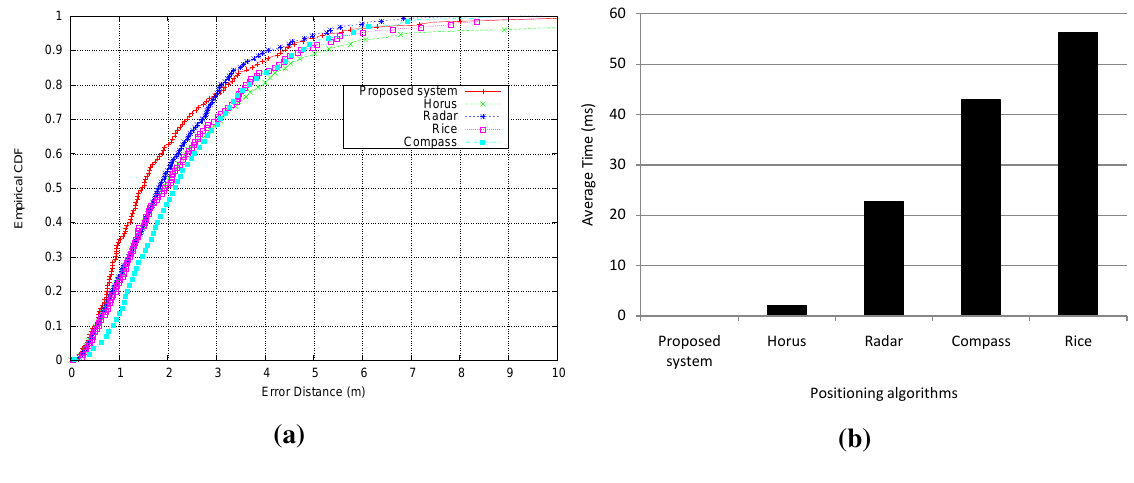
Figure 8. Evaluation of different positioning algorithms: ( a ) CDF of performance; ( b ) elapsed time to estimate a location.